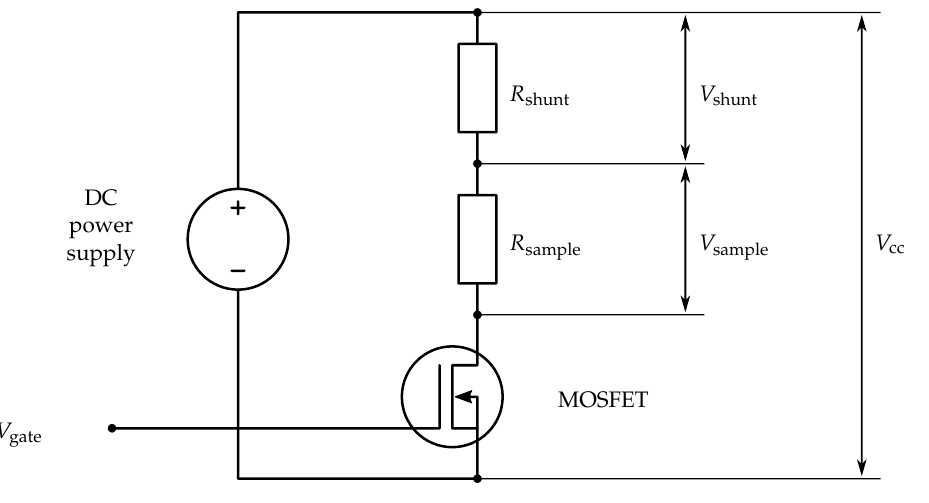
Figure 10. Measurement